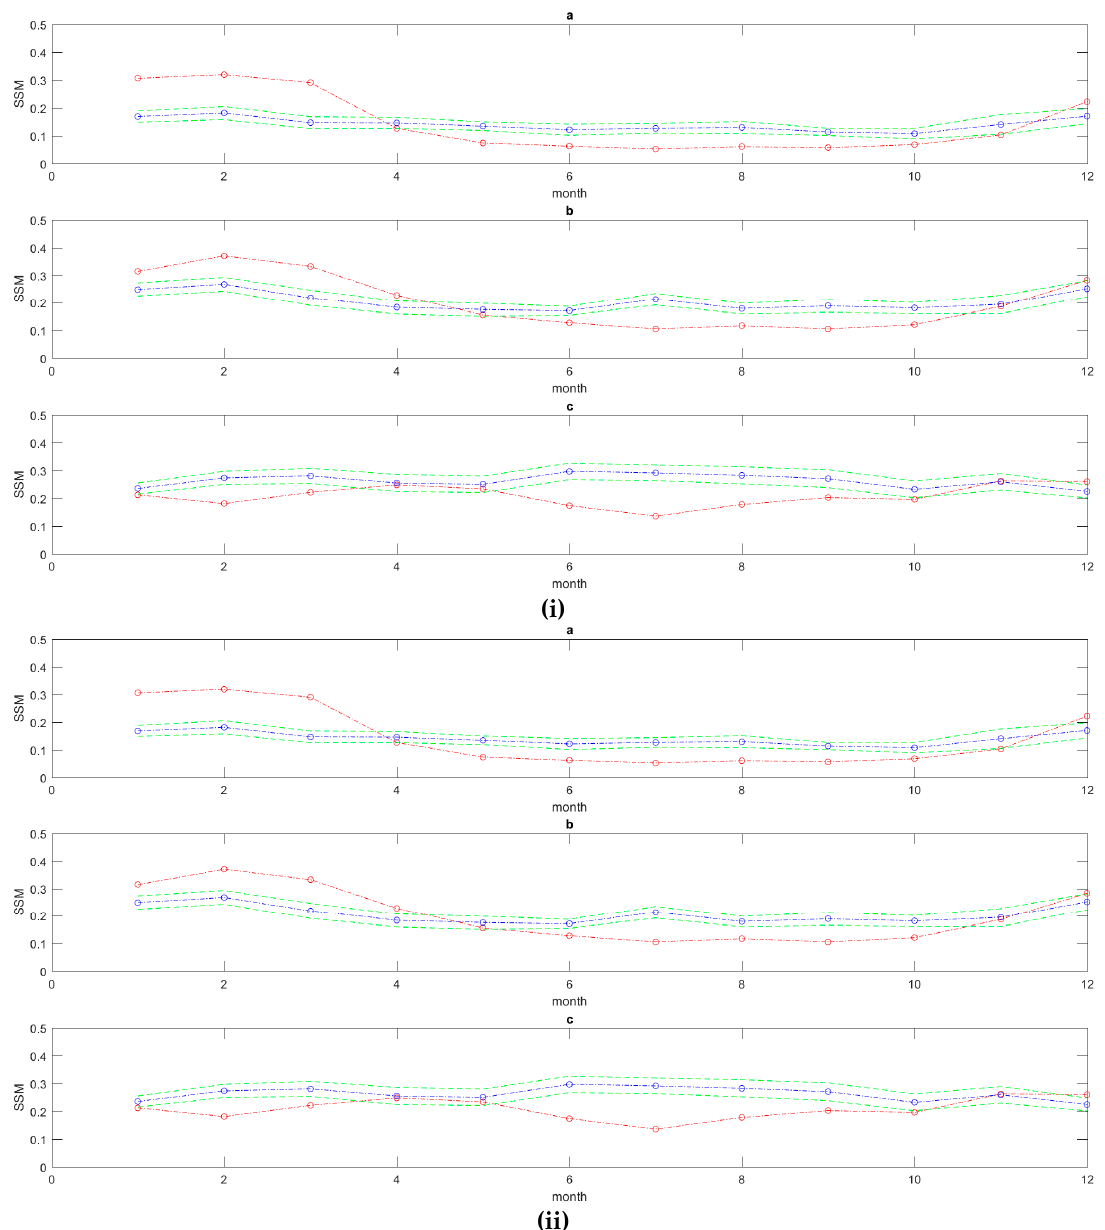
Figure 3. Temporal dependence of monthly averages of in situ and predicted SSM from ASCAT 25km for the different land cover types throughout in EUROPE. Results are shown for: ( a ) ES_AGU, ( b ) ES_LJU, and ( c ) IT_Ren. The blue curves represent the ASCAT SSM, the red curves represent the in situ SSM. ( i ) 2010 and ( ii ) 2011. The green dashed lines represent the 95% confidence level. Table 3. Comparison per season between Satellite (ASCAT 25Km) and observed SSM at all validation sites in EUROPE for 2010 and 2011.